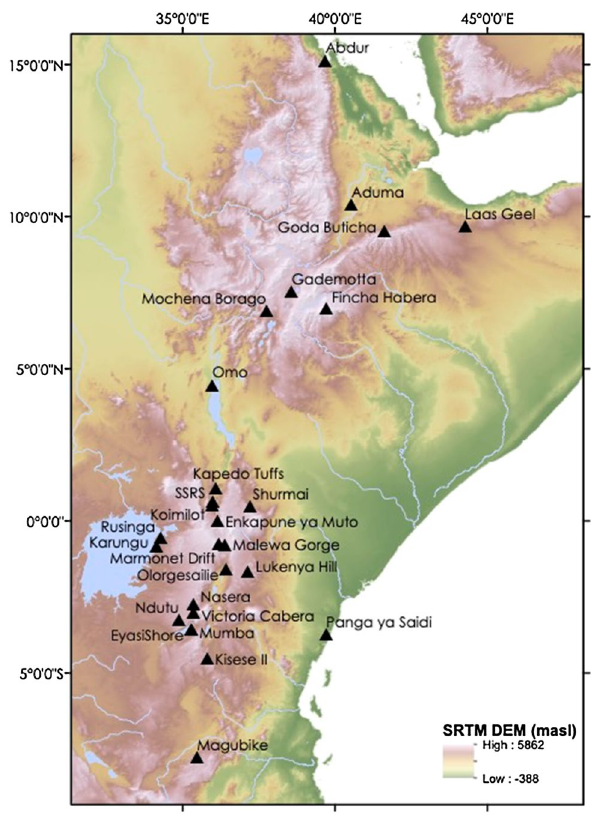
Figure 2. Distribution of the eastern African Middle Stone Age occupations studied. This map was created in ArcGIS 10.5 using an SRTM